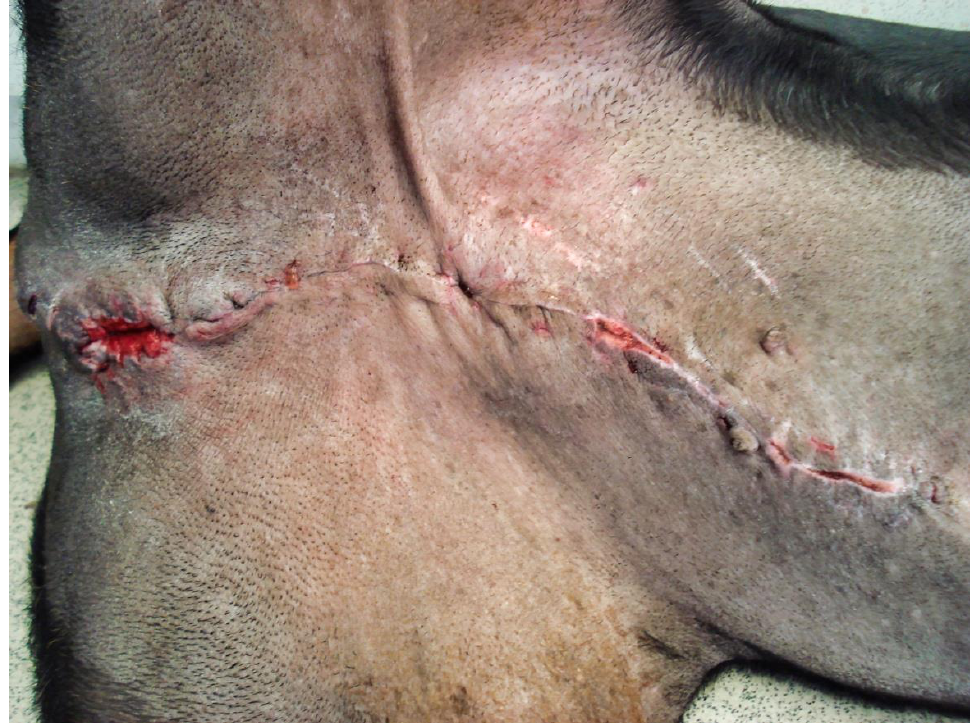
Figure 10. Urethrostomy wound and skin wound the tenth day following the surgery.